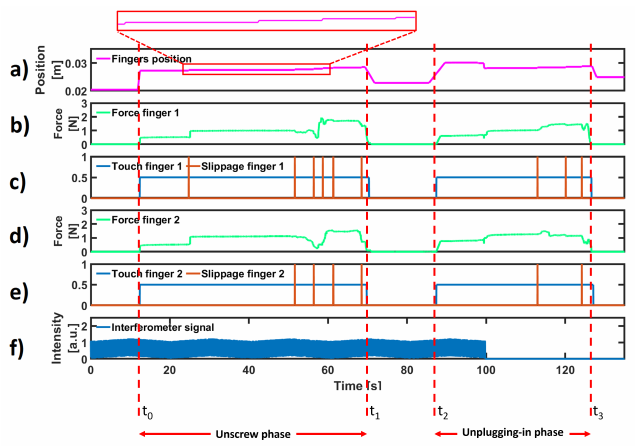
Figure 8. Experimental results for a single unplugging task. ( a ) Position of each finger. ( b , d ) Nor- mal forces acquired by the FSR sensors on the fingers. ( c , e ) Detected touch and slippage events. ( f ) Interferometer